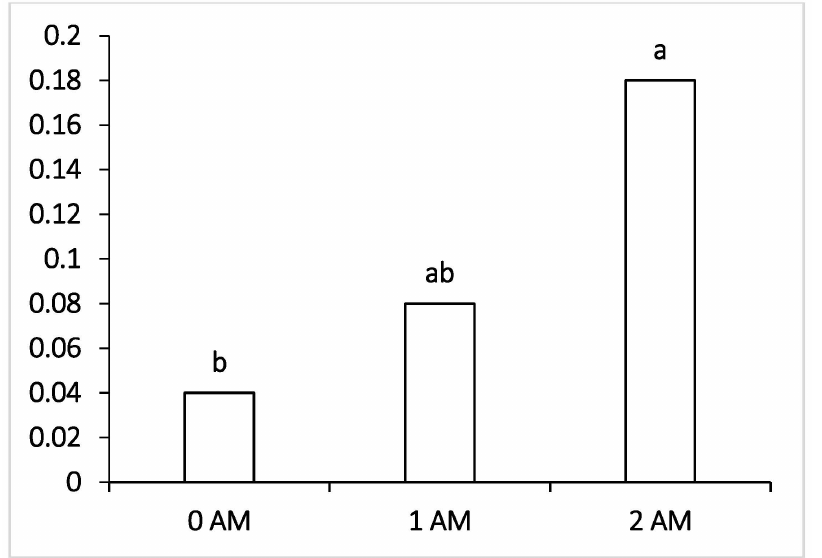
Figure 3. Effect of Agro-Matic supplementation on the rumen undesirable microflora ( Lactobacil- lus